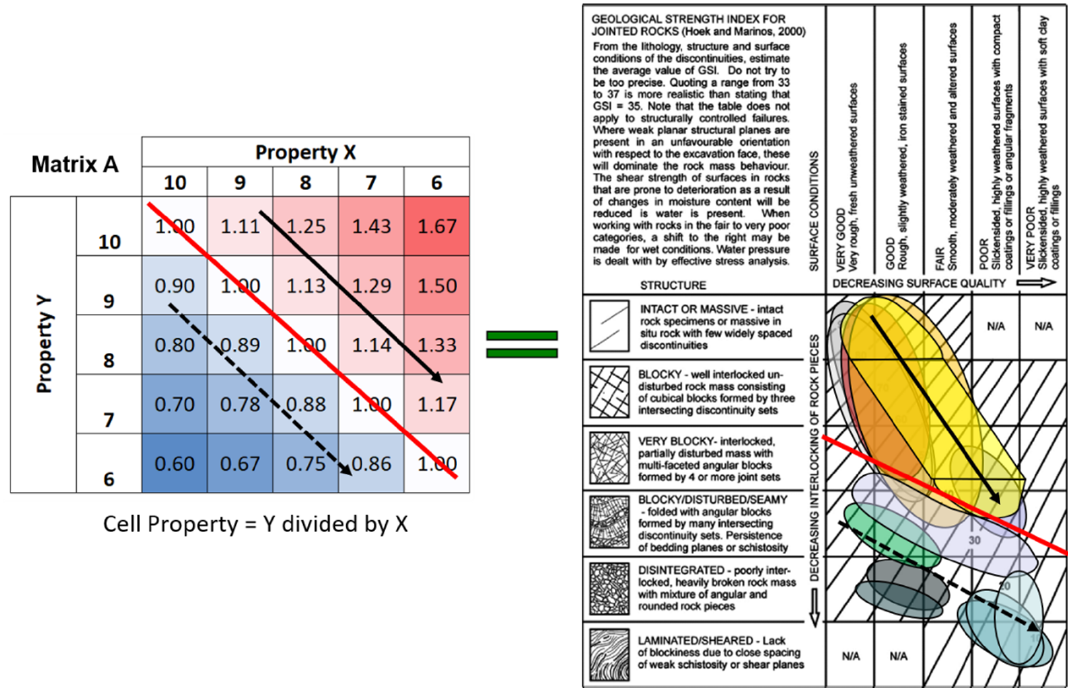
Figure 8. Comparison between Matrix A and the GSI system [45] when new (geological) knowledge is included.